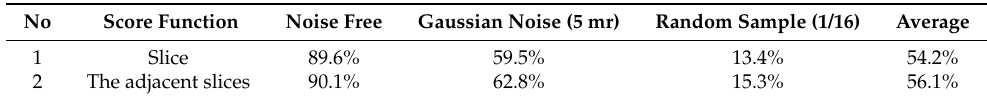
Table 2. The effects of different slice strategies on the